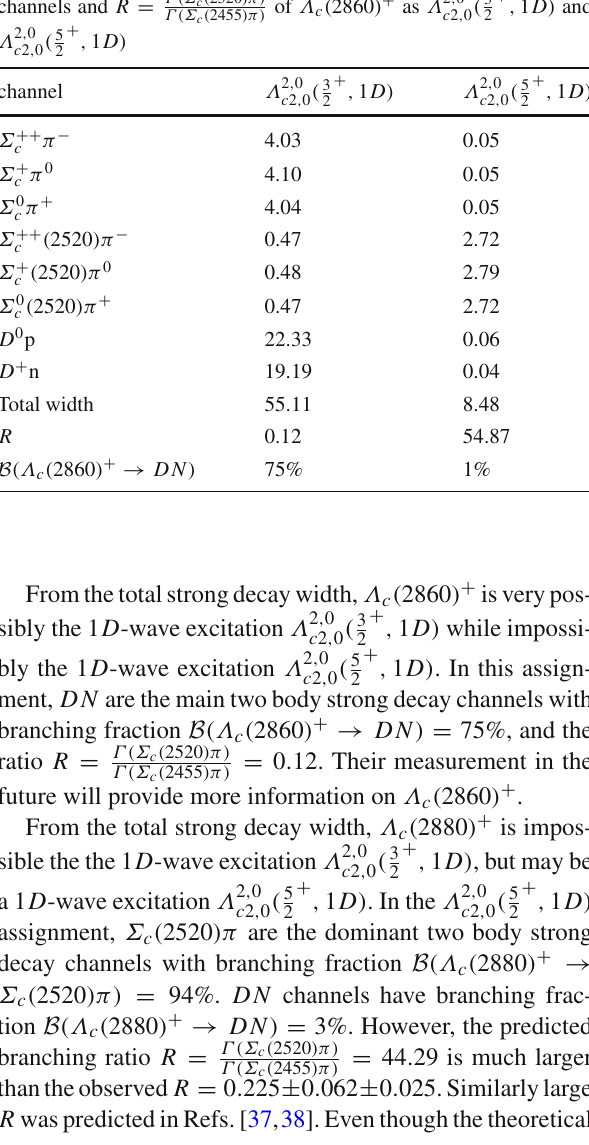
Table 2 Possible decay widths (MeV), branching fraction of